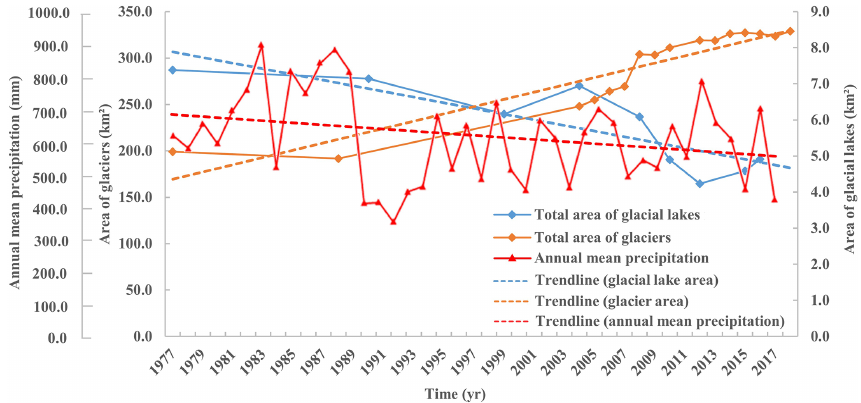
Figure 13. Changes in the area of the five typical glacial lakes and glaciers vs.